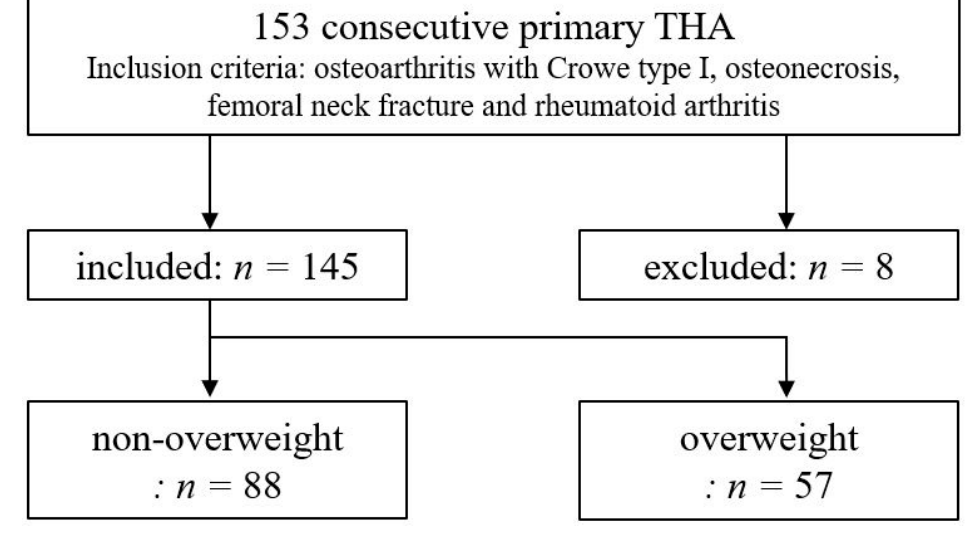
Figure 1. Study workflow.